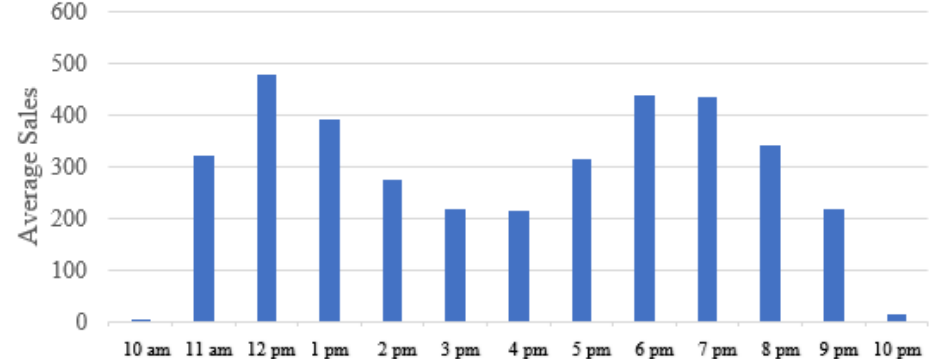
Figure 1. Average Hourly Sales Over the Entire Dataset. The restaurant is open from 10:00 A.M.–10:59 P.M., and we show the average sales in dollars for each hour using the entire dataset. The shape of the dataset is marked with two peak rush periods and one slow period, which we partition around.